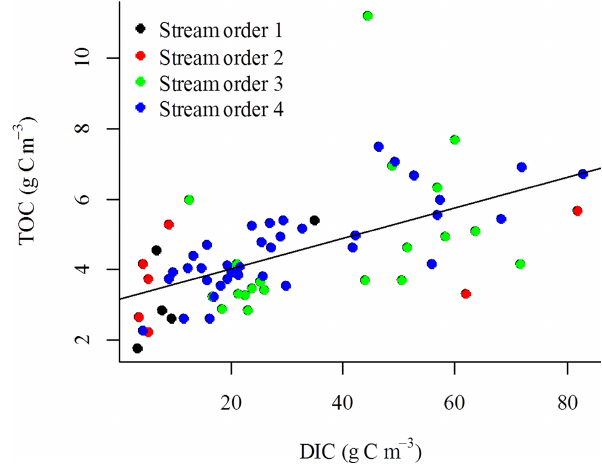
Figure 2. TOC versus DIC concentration. Different colors indicate sampling sites from different stream orders. The solid line shows the fitted linear regression model with TOC=0.04 · DIC ( r 2 = 0 . 33, p< 0 .